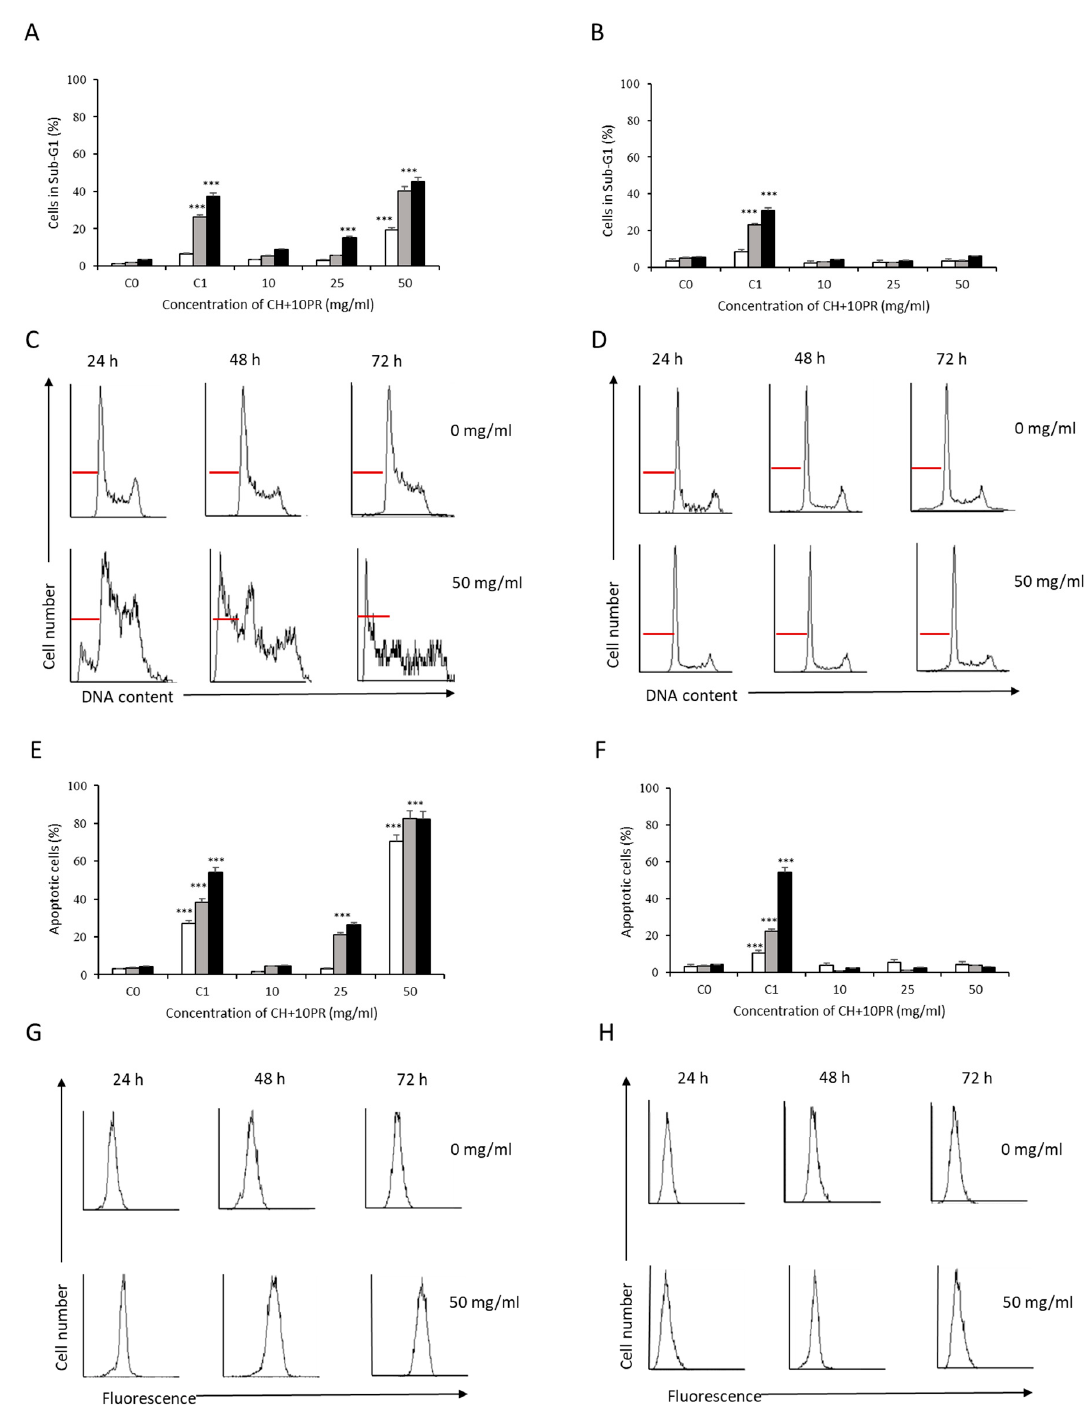
Figure 9. Effect of sample 10 (CH+10PR) on human liver cell apoptosis. The cell cycle was determined using flow cytometry. HepG2 ( A ) and WRL-68 ( B ) cells were treated with different doses of sample 10 (10, 25, and 50 mg/mL) for 24 ( □ ), 48 ( ■ ), and 72 h ( ■ ). Representative histograms of the cell cycle of HepG2 ( C ) and WRL-68 ( D ) cells are shown; the red line indicates the sub-G1 phase. The percentage of apoptosis was analyzed by flow cytometry using the TUNEL assay. HepG2 ( E ) and WRL-68 ( F ) cells were cultured with different doses of sample 10 (10, 25, and 50 mg/mL) for 24 ( □ ), 48 ( ■ ), and 72 h ( ■ ). Representative histograms of the fluorescence intensity in HepG2 ( G ) and WRL-68 ( H ) cells are presented. C 0 , untreated cells; C 1 , cells treated with etoposide (50 µM). Asterisks indicate a significant difference from the control (C 0 ). *** p ≤ 0.001.